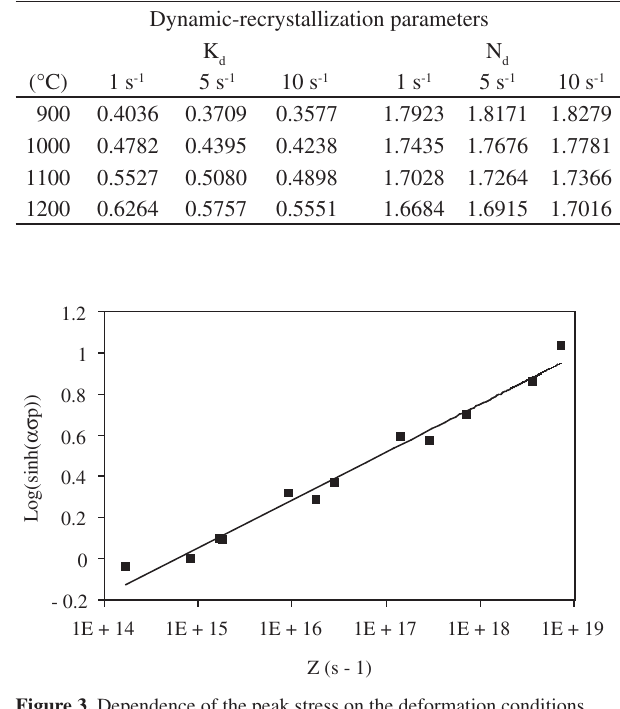
Figure 3. Dependence of the peak stress on the deformation